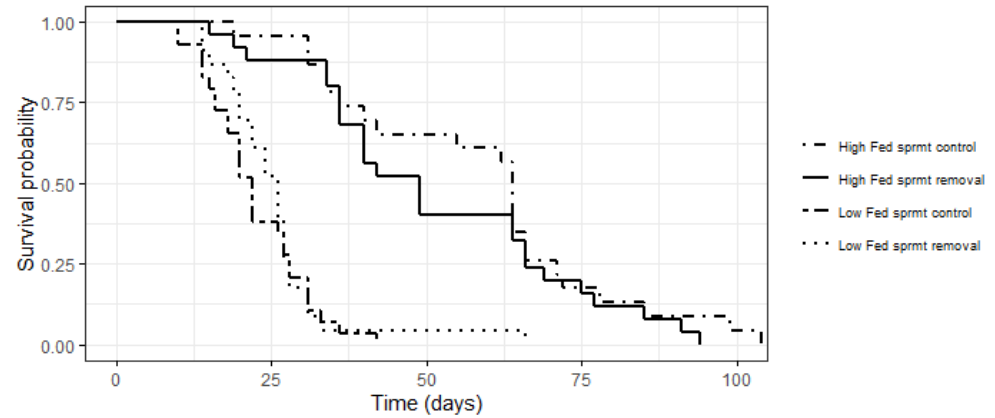
Figure 5. Lifetime survival probabilities of males exposed to high and low feeding treatments (high-fed and low-fed), with and without experimental spermatophore removal (respectively, sprmt-removal and sprmt-control).